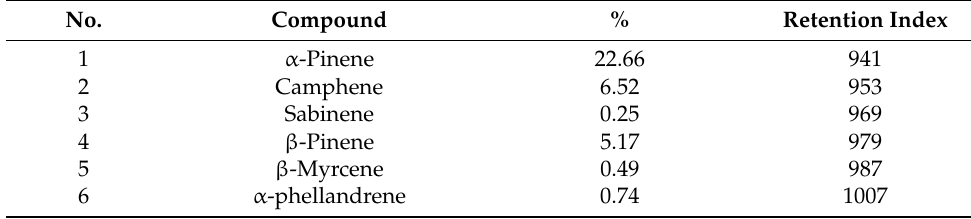
Figure 4. The effect of ( a ) pressure at a constant temperature of 318 K and particle diameter 0.15 mm ( b ) temperature at a constant pressure of 15 MPa and particle diameter 0.15 mm, and ( c ) Particle diameter at a constant pressure of 15 MPa and temperature of 318 K, on the yield of rosemary essential oil extraction. Table 3. Chemical composition of rosemary essential oil by